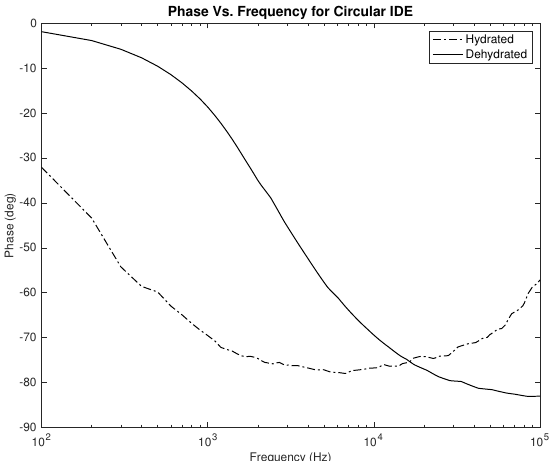
Figure 10. Simulation results—phase (Degree) of hydrated and dehydrated skin using the rectangular IDE design.